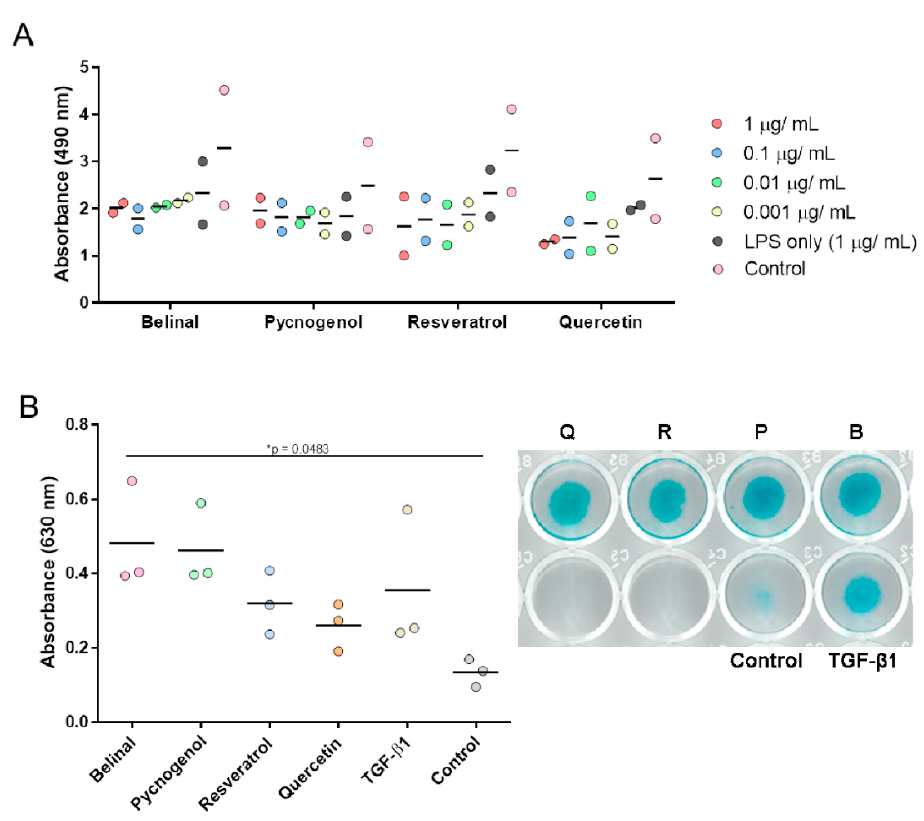
Figure 3. Chondrogenesis under inflammatory conditions. ( A ) Cell proliferation screening to determine the optimal lipopolysaccharide (LPS) concentration for further experiments, using the MTS assay. Serial dilutions of LPS (1, 0.1, 0.01, 0.001 µ g / mL) were added to the primary hMSCs for 18 h, to simulate inflammatory conditions. After 18 h, the medium was changed and the polyphenolic extracts and polyphenols were added at 375 mg / mL. No significant di ff erences in viability (as measured at 490 nm in the MTS assay) were seen between the serial dilutions of LPS. LPS at 0.01 µ g / mL was used for further experiments based on previous studies [25,26]. Each concentration of LPS for each treatment was tested in duplicate. ( B ) Chondrogenic di ff erentiation was determined using the hMSCs from patients with hip osteoarthritis ( n = 3) in the micromass assay. Micromasses were pretreated with 0.01 µ g / mL LPS for 18 h, and then treated with the polyphenolic extracts and polyphenols, with the addition of TGF- β 1 for 7 days. After 7 days, Alican blue staining was performed as the measure of chondrogenesis. Belinal showed significantly greater absorbance of extracted Alcian blue in comparison with the controls that only received cell medium. B, Belinal; P, Pycnogenol; R, resveratrol; Q, quercetin.